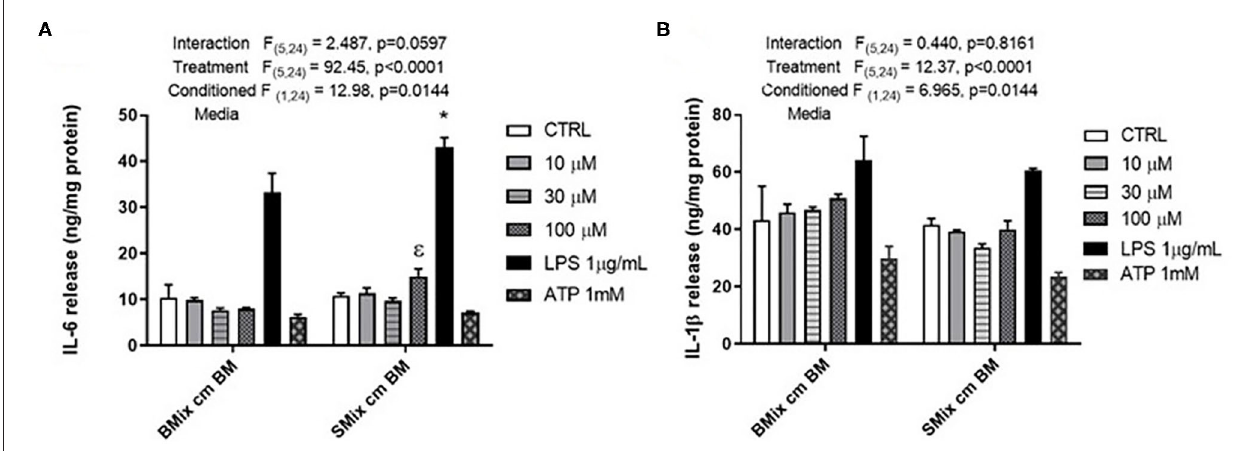
FIGURE 3 | Secretion of the pro-inflammatory cytokines by BM exposed to BMix CM and SMix CM. (A) Two-way ANOVA also revealed a significant main effect of conditioned media and treatment for IL-6 release. ε represents significant difference for 100 µ M glutamate treatment ( p = 0.0480) between brain mixed glia conditioned media (BMix CM) and spinal mixed glia conditioned media (SMix CM) * represents p < 0.05 significant difference between LPS treatment for BMix CM and SMix CM as revealed by the Sidak post-hoc test, n = 3 where n represent the number of independent experiments. (B) Two-way ANOVA revealed a significant main effect of conditioned media and treatment for the release of IL 1 β . However, the Sidak post-hoc test did not reveal any significant differences between BMix CM and SMix CM ( n = 3). Bars represent mean ± s.e.m.